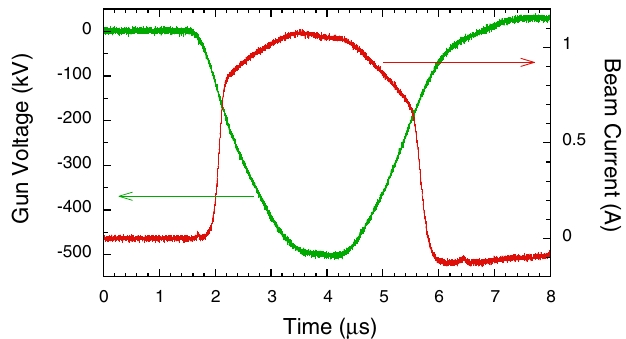
FIG. 5. (Color) Waveform of the gun voltage and beam current.